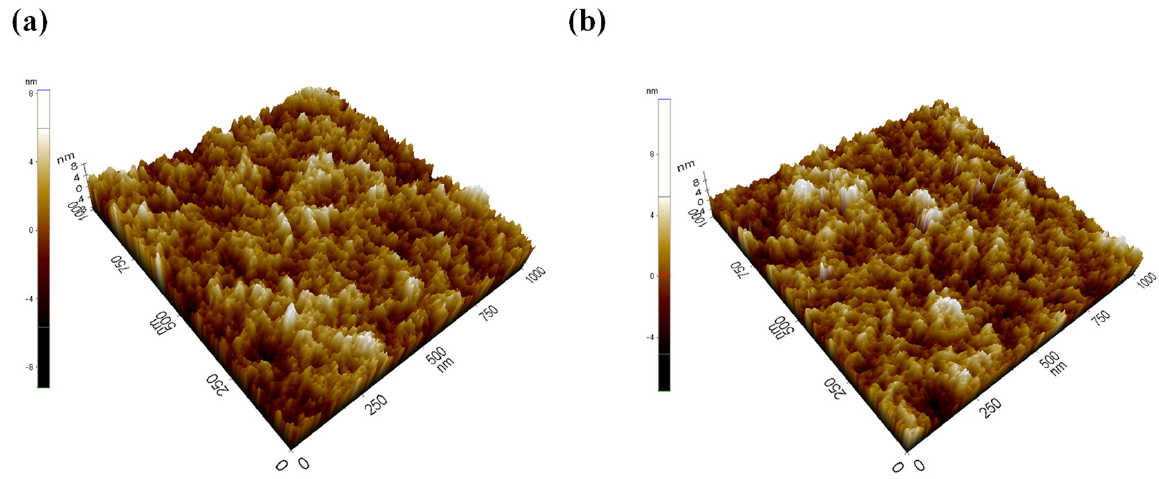
Figure 10. Three-dimensional AFM images of PEDOT: PSS without and with different organic ad- ditives and subjected to multi-FA treatment: ( a ) PEDOT: PSS, ( b ) PEDOT: PSS-maltitol (4 wt%), ( c ) PEDOT: PSS-sorbitol-maltitol (4wt%; 3:1). Table 5. Transmittance, haze, sheet resistance, conductivity, and R q of PEDOT: PSS without and with different organic additives and subjected to multi-FA treatment. Sample Transmittance